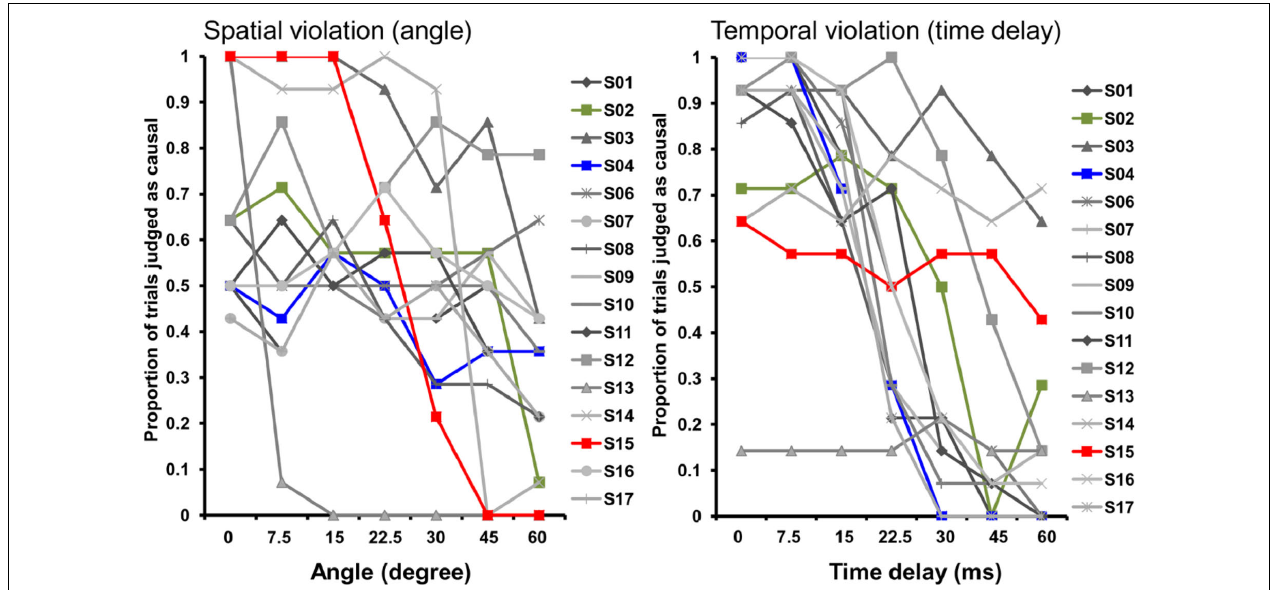
FIGURE 3 | Individual differences in causality judgments with regard to spatial and temporal violations. Illustrates the individual differences in the proportion of causality judgments separate for each subject and divided for angle and time manipulations. Each data-point represents the mean of all 14 trials